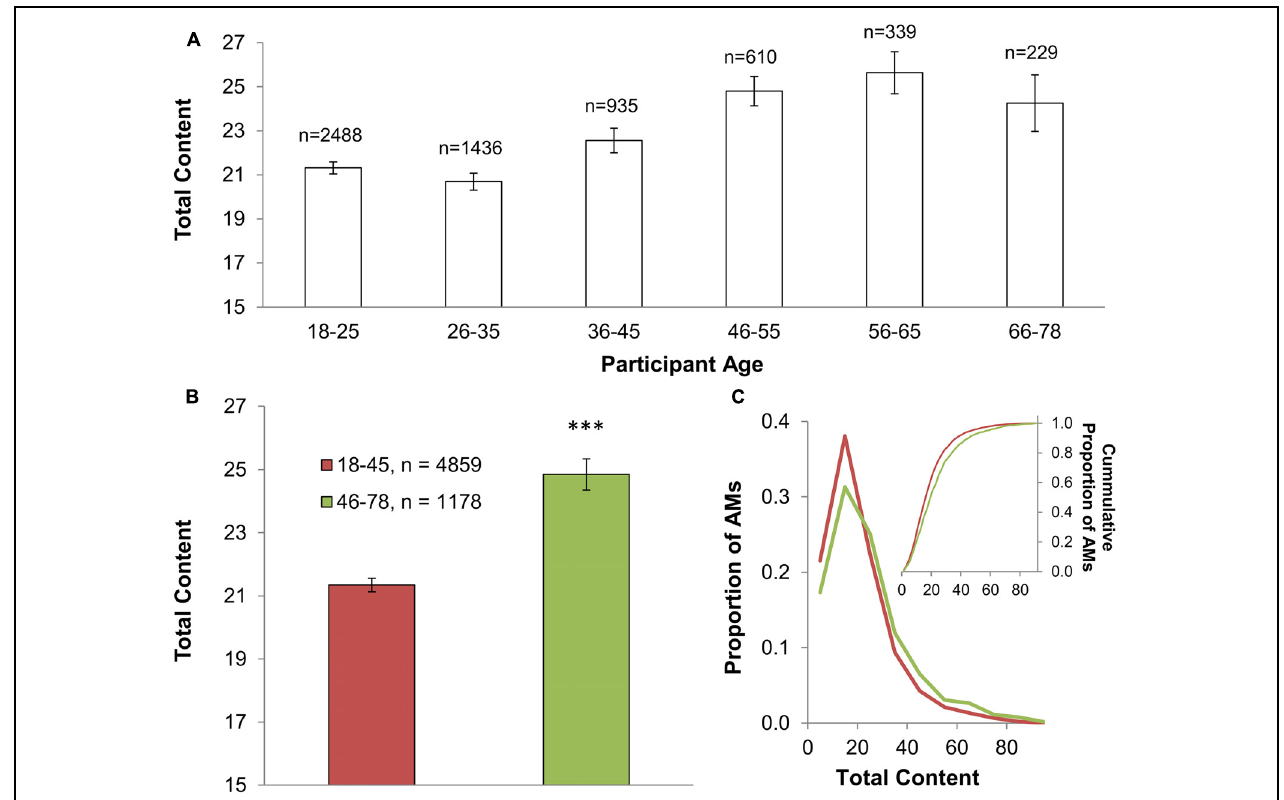
FIGURE 2 | Moderate increase of total reported content in older individuals. The total number of unique details reported for a given AM is displayed for various age groups ( n : number of scored AMs; error bars: SEM; ∗∗∗ p < 0.001). (A) Total content moderately increased with the age of the participant, most noticeably in subjects older than 45 years old, an effect that